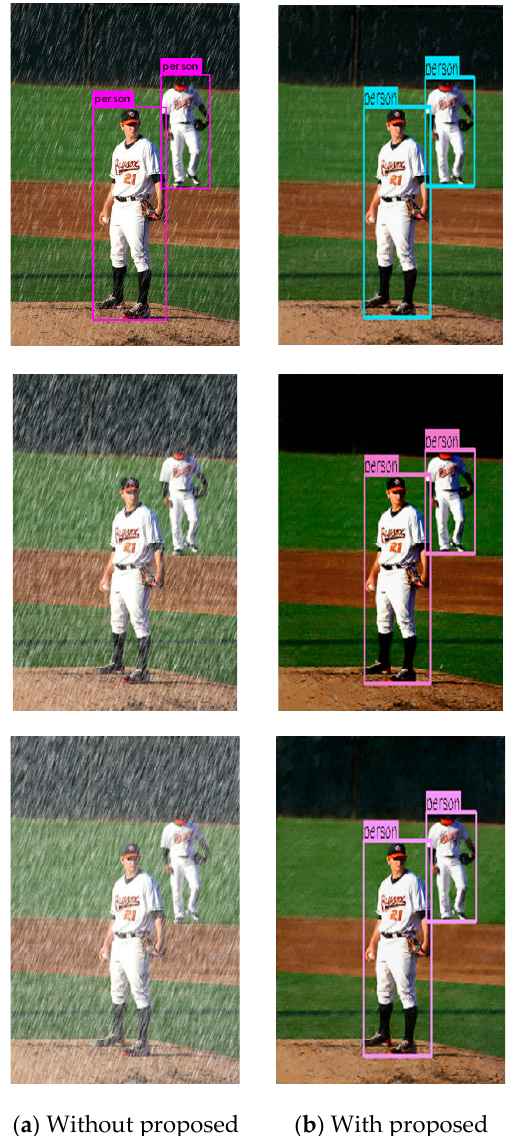
Figure 11. Qualitative sample comparison of the proposed algorithm.